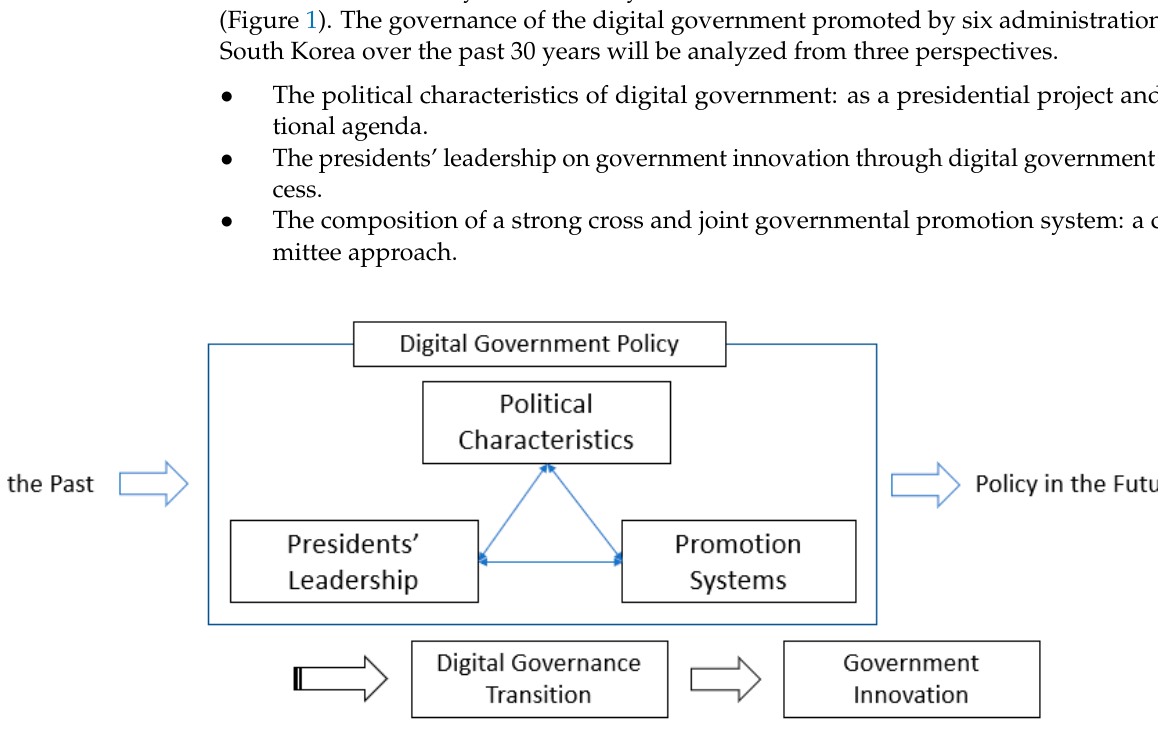
Figure 1. Research Framework.